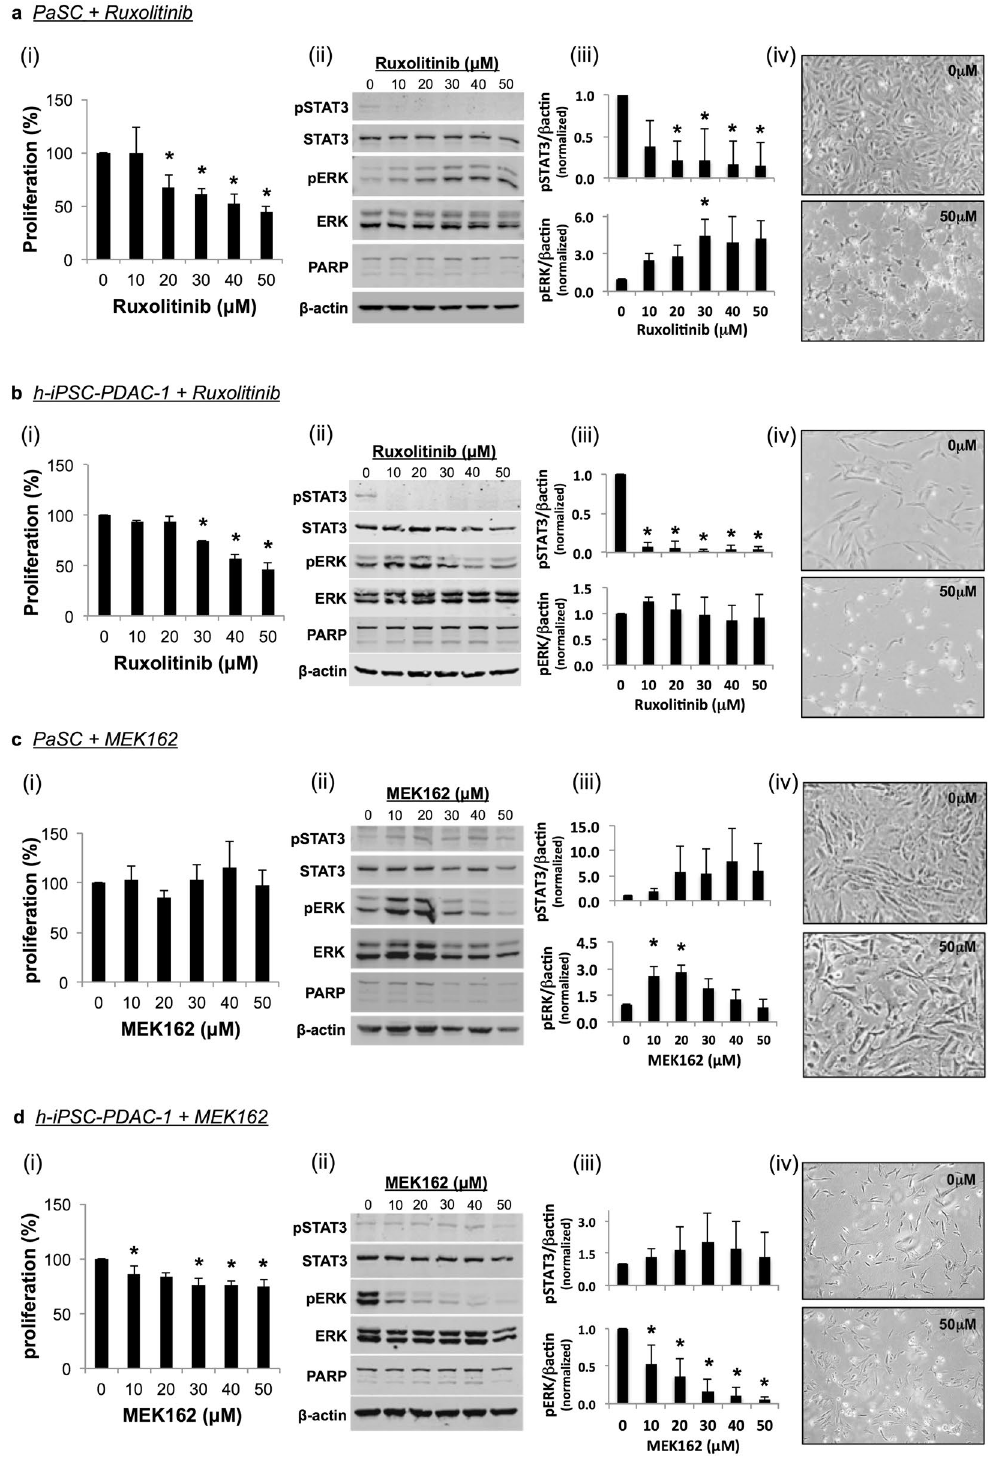
Figure 3. Effect of Jak/STAT and MEK inhibition on PSC proliferation in vitro . (a,c ) PaSC or (b,d) h-iPSC- PDAC-1 were treated with ruxolitinib (a,b) or MEK162 (c,d) . (i) After 24 hours of incubation, cell proliferation was analyzed by MTT assay. (ii) Lysates were also taken at 24 hours and analyzed by western blot. β -actin served as a loading control. (iii) Results were quantified via densitometry and normalized to β -actin. Graphs display mean ± STD from 3 biological replicates ( * indicates p < 0.05). ( iv ) Light microscopy images were taken of treated cells following 72 hours of incubation (40X